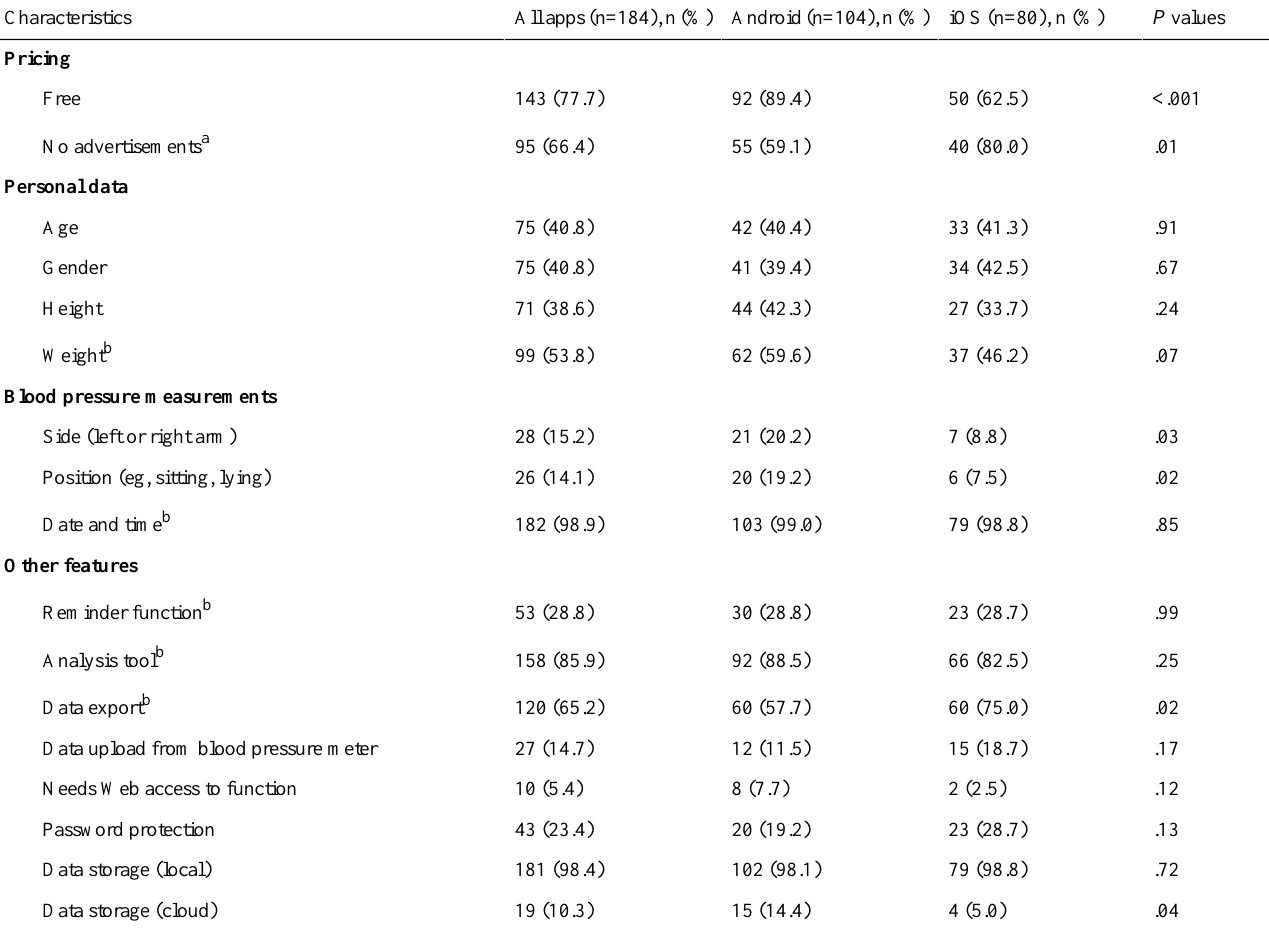
Table 1. Summary of characteristics of included apps, stratified by